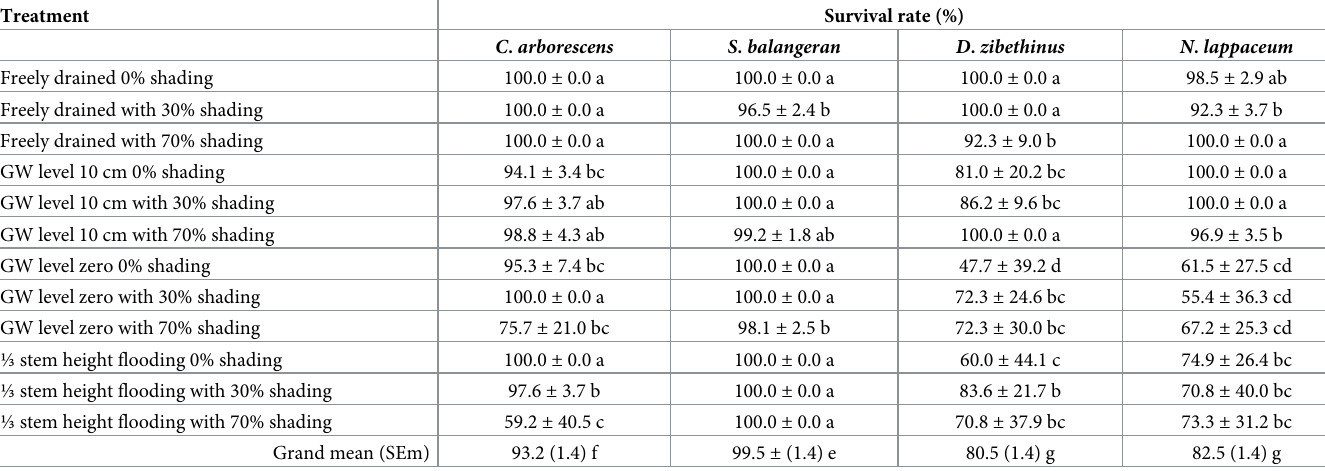
Table 2. Survival rate of four plant species under different treatment.